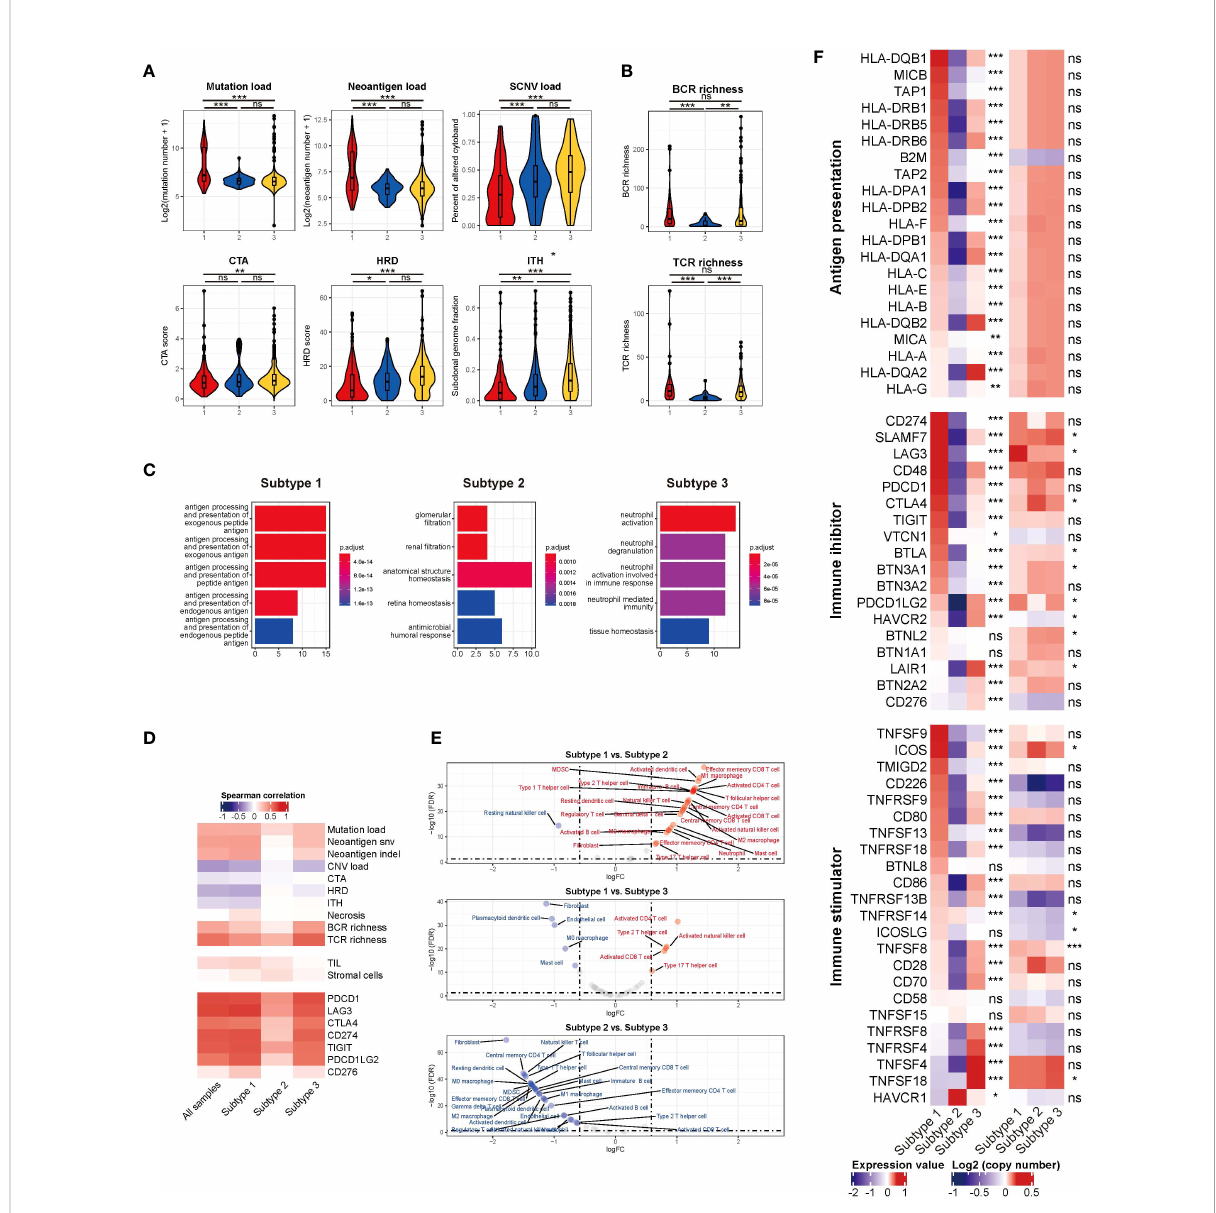
FIGURE 3 (A) The mutation load, neoantigen load, SCNV load, CTA, HRD, and ITH among TMEC subtypes. (B) The BCR and TCR richness of different subtypes. (C) Pathways enriched in tumor cells among TMEC subtypes in the scRNA-seq cohort. (D) The correlation between immune cytolytic activity and tumor immunogenicity factors, TILs, stromal cells, and immune checkpoint molecules. (E) The comparison of each cell type between subtypes. (F) The relative expression levels to the median value and mean log2(copy number) value of immune inhibitors and immune stimulators among three subtypes. ***P < 0.001; **0.001 < P < 0.01; *0.01 < P < 0.05; ns: P >